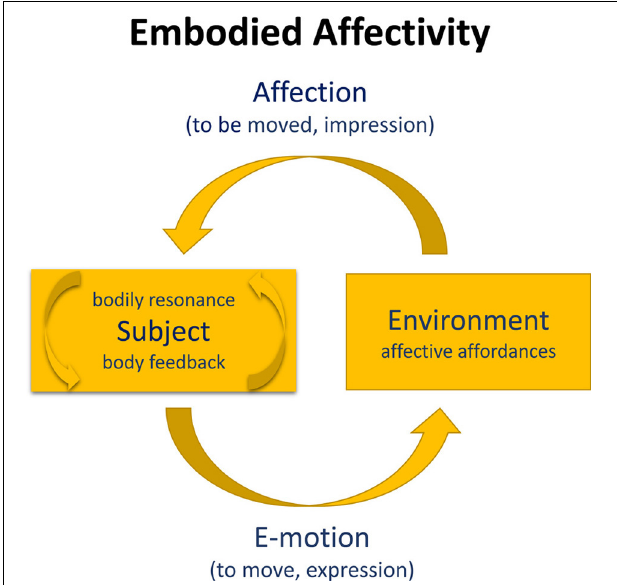
FIGURE 1 | Embodied affectivity. We use phenomenological terminology in the model; in psychological terminology subject could be replaced by person , and affection by affect . Expression is constitutive of e-motion (centrifugal), impression is constitutive of affection (centripetal), resulting in interoceptive and proprioceptive body feedback or bodily resonance (arrows in subject ). Emotion is mediated by the expressive ability (e.g., Laban, 1980), and affection is mediated by the permeability of the person system (Lewin, 1935). Both expression and impression (Wallbott, 1990) constitute the unity of movement and perception (cf. Weizsäcker, 1940), and form an integral part of our personality